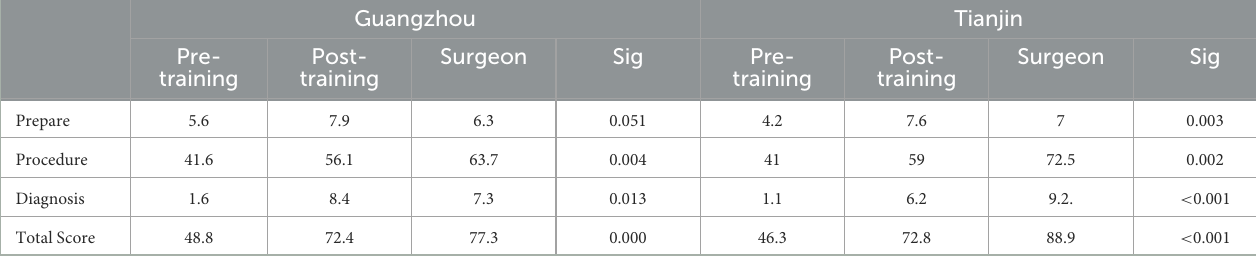
TABLE 2 Comparison of mean checklist scores across each group between the two